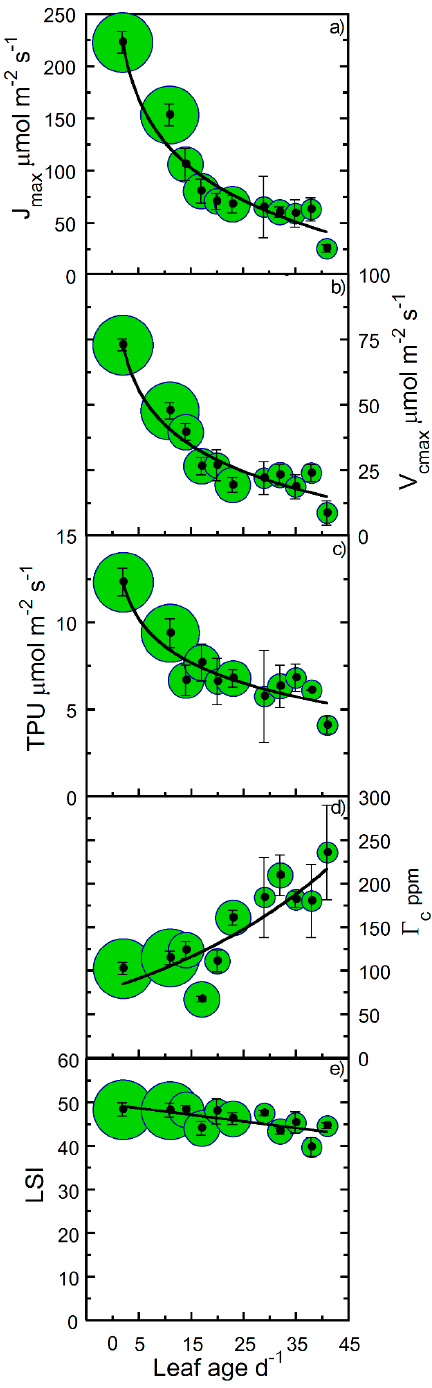
Figure 4. Maximum electron transport rate (J max ), maximum Rubisco carboxylation rate (V cmax ), triose phosphate utilization (TPU), CO 2 compensation point ( Γ c ), and leaf spectral index (LSI) of hemp leaves as a function of leaf age. Binned averages per three-day collection sequence (means ± SE), where samples were pooled for treatments and crown position. Measured changes in ( a ) J max , ( b ) V cmax , ( c ) TPU, ( d ) Γ c , and ( e ) LSI (a proxy for leaf nitrogen content, chlorophyll a + b concentration, and greenness characteristics). Sample size in bins indicated by bubble diameter (n = 3–18 for J max , V cmax , TPU, Γ c , and LSI). Solid lines are logarithmic (panels a–d) and linear (panel e) regressions fitted to the entire data set.